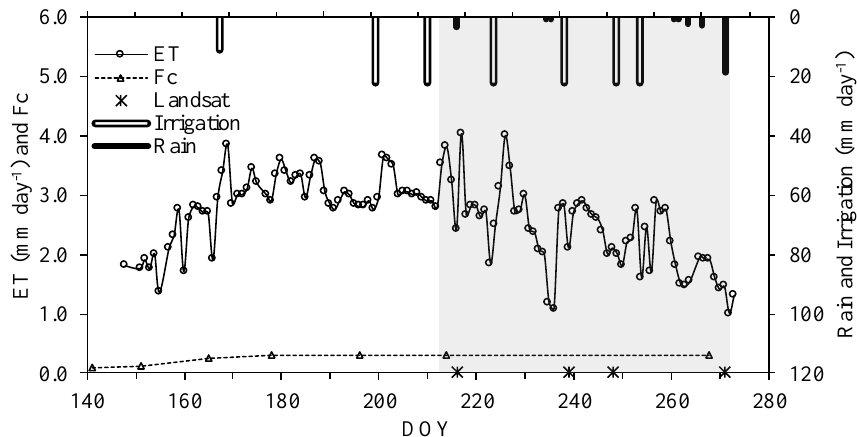
Figure 2. A plot of vineyards fraction of cover (Fc), actual evapotranspiration (ET) based on EC measurements, irrigation dates for Field 7, LAS measurements period, and Landsat overpass dates with respect to day of year (DOY) for year 2007.